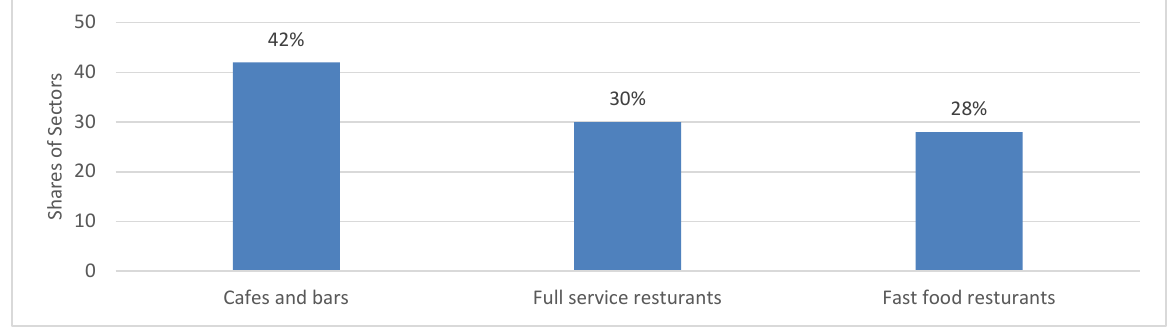
Fig. 1 . Market share of food and beverage industry in UAE